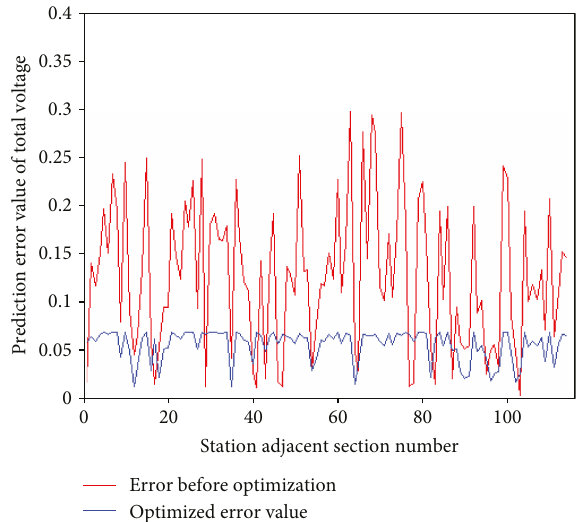
Figure 9: In fl uencing factor prediction error of RBF neural network before and after optimization (brake mileage proportion).